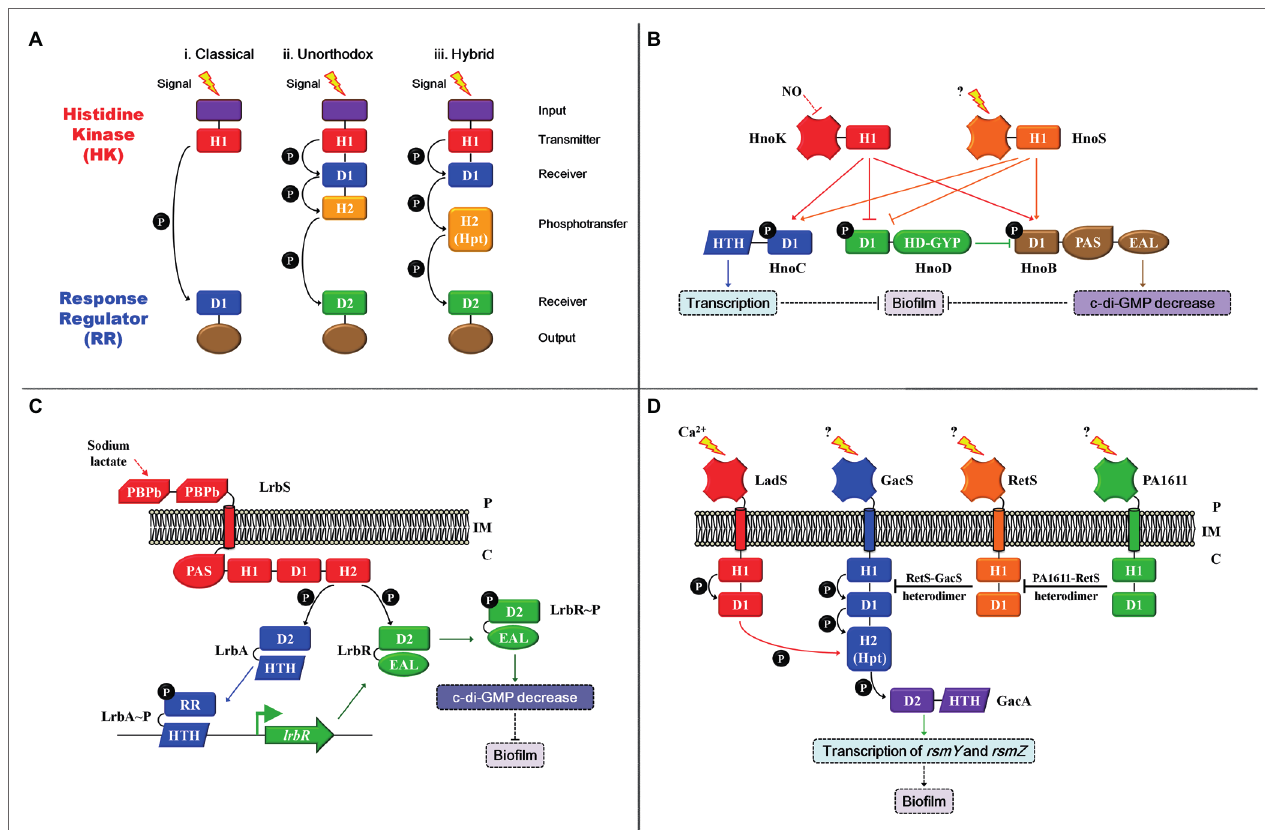
FIGURE 1 | Two-/three-/multi-component signal transduction system modulation patterns. (A) (i) The classical version comprises an N-terminal input domain (purple), followed by a transmitter (H1) domain (red) with a conserved histidine that can be autophosphorylated in histidine kinase (HK). The phosphoryl group (P) can be transferred to a conserved aspartic residue in the receiver (D1) domain (blue) in the response regulator (RR). The classical version is a two-step phosphorelay mechanism; (ii) in the unorthodox version, the H1 domain is followed by an additional conserved aspartic residue (D1) and an H2 (yellow) domain in the C-terminal of HK. The phosphoryl group (P) can be transferred to a conserved aspartic residue in the receiver (D2) domain (green) in the RR. The unorthodox version is a four-step phosphorelay mechanism. (iii) the hybrid version is similar to the unorthodox version. The only difference is that the H2 (Hpt) domain of the hybrid version is an external phosphotransfer module that acts as an individual protein. (B) The modulation mode of the Hno-multi-component signal transduction system. (C) The modulation mode of the Lrb-three-component signal transduction system. (D) The modulation mode of the Gac-multi-component signaling transduction system; the red arrow indicates that the phosphoryl group (P) can be transferred from the D1 domain of LadS to the H2 domain of GacS. Arrows indicate activation, and the flat end represents inhibition. Solid arrows indicate direct regulation, and dashed arrows represent indirect regulation. Inner membrane (IM), periplasm (P), cytoplasm